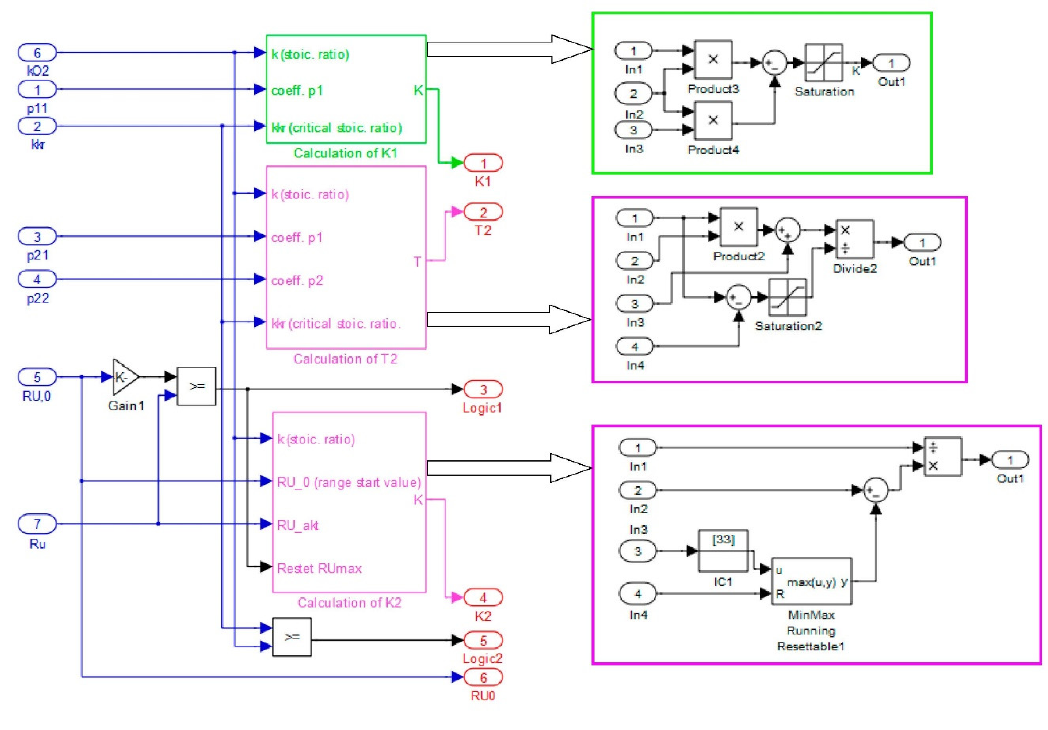
Energies 2020 , 13 , x FOR PEER REVIEW Figure 11. Step for calculation of model parameters. Figure 11. Step for calculation of model parameters.